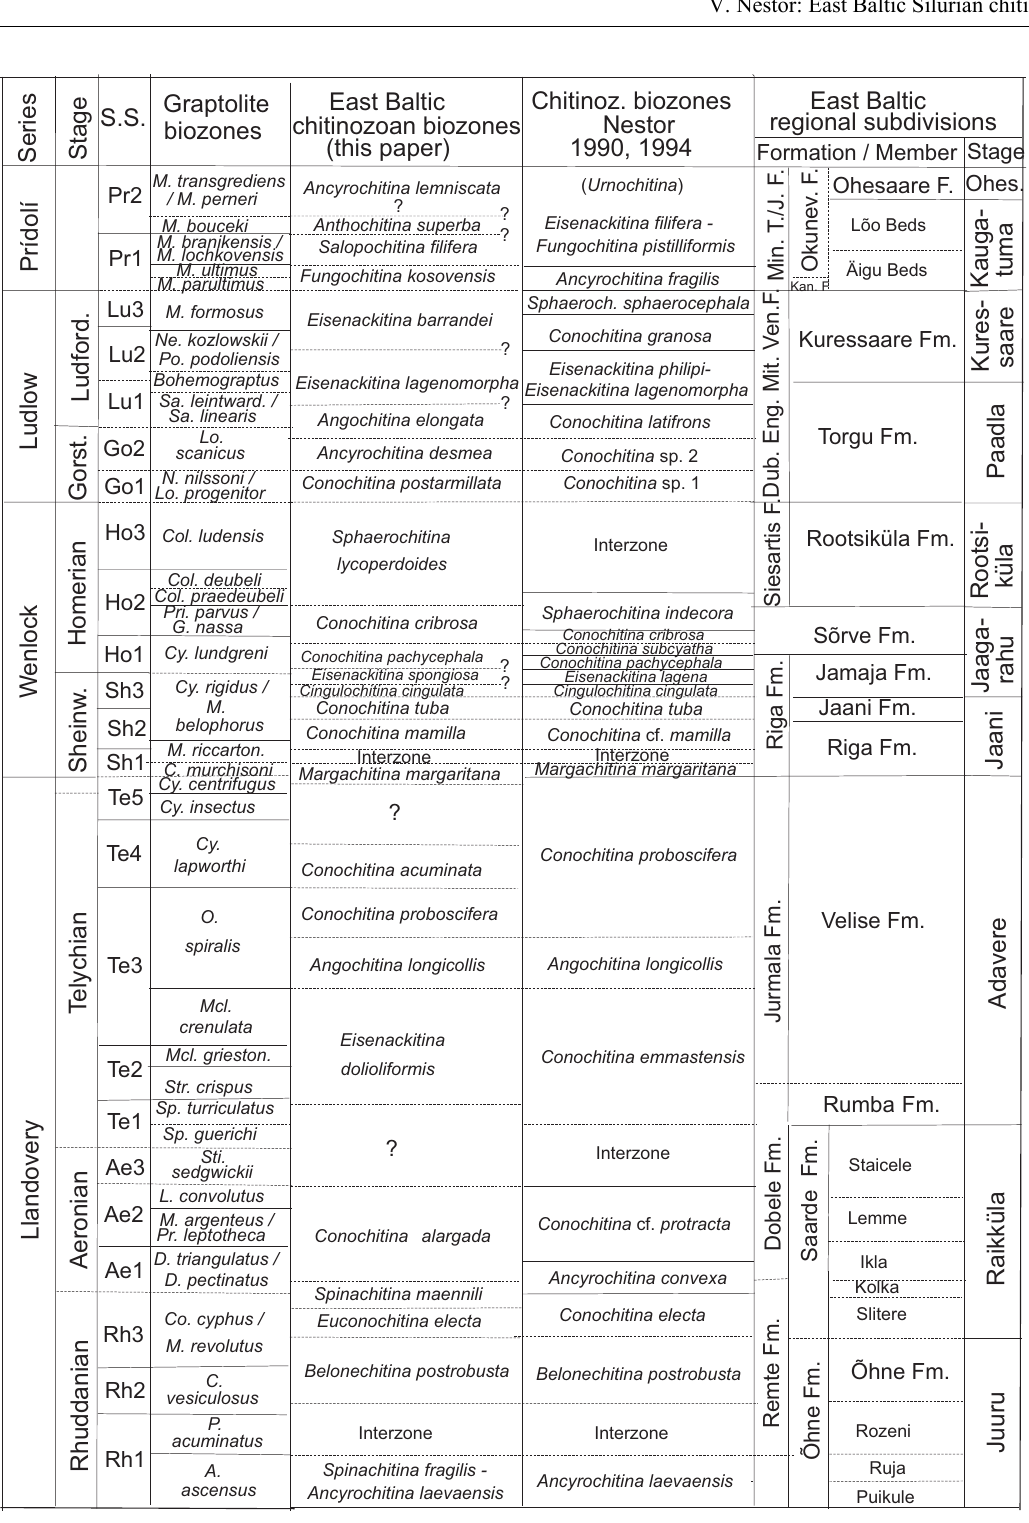
Fig. 3. Correlation of the East Baltic chitinozoan biozones with the global graptolite biozones and Silurian stage slices (S.S.) (after Cramer et al. 2011), as well as regional stratigraphical subdivisions of Estonia (after H. Nestor 1997), Latvia (after Gailite et al. 1987) and Kaliningrad district (Pridoli) (after Koren et al. 2009). Abbreviations: Dub., Dubysa; Eng., Engure; Mit., Mituva; Ven., Ventspils; Min., Minija; T., Targale; J., Jura; Kan., Kandievski; Okunev., Okunevski; Ohes., Ohesaare; Fm., F.,